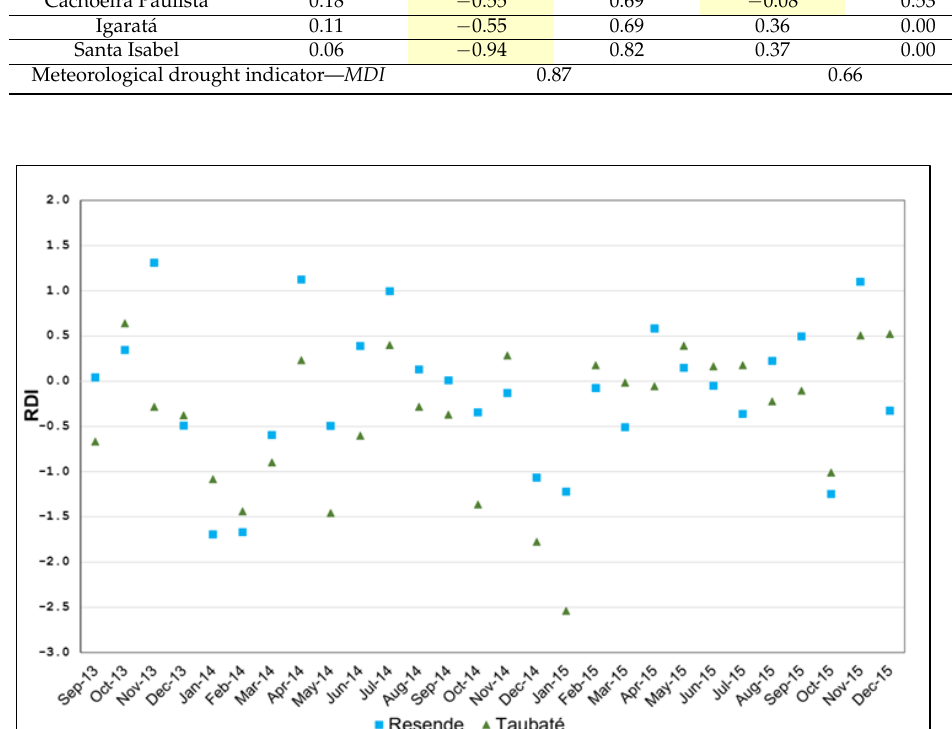
Figure 8. Monthly RDI of rainfall gauges in the region under study.